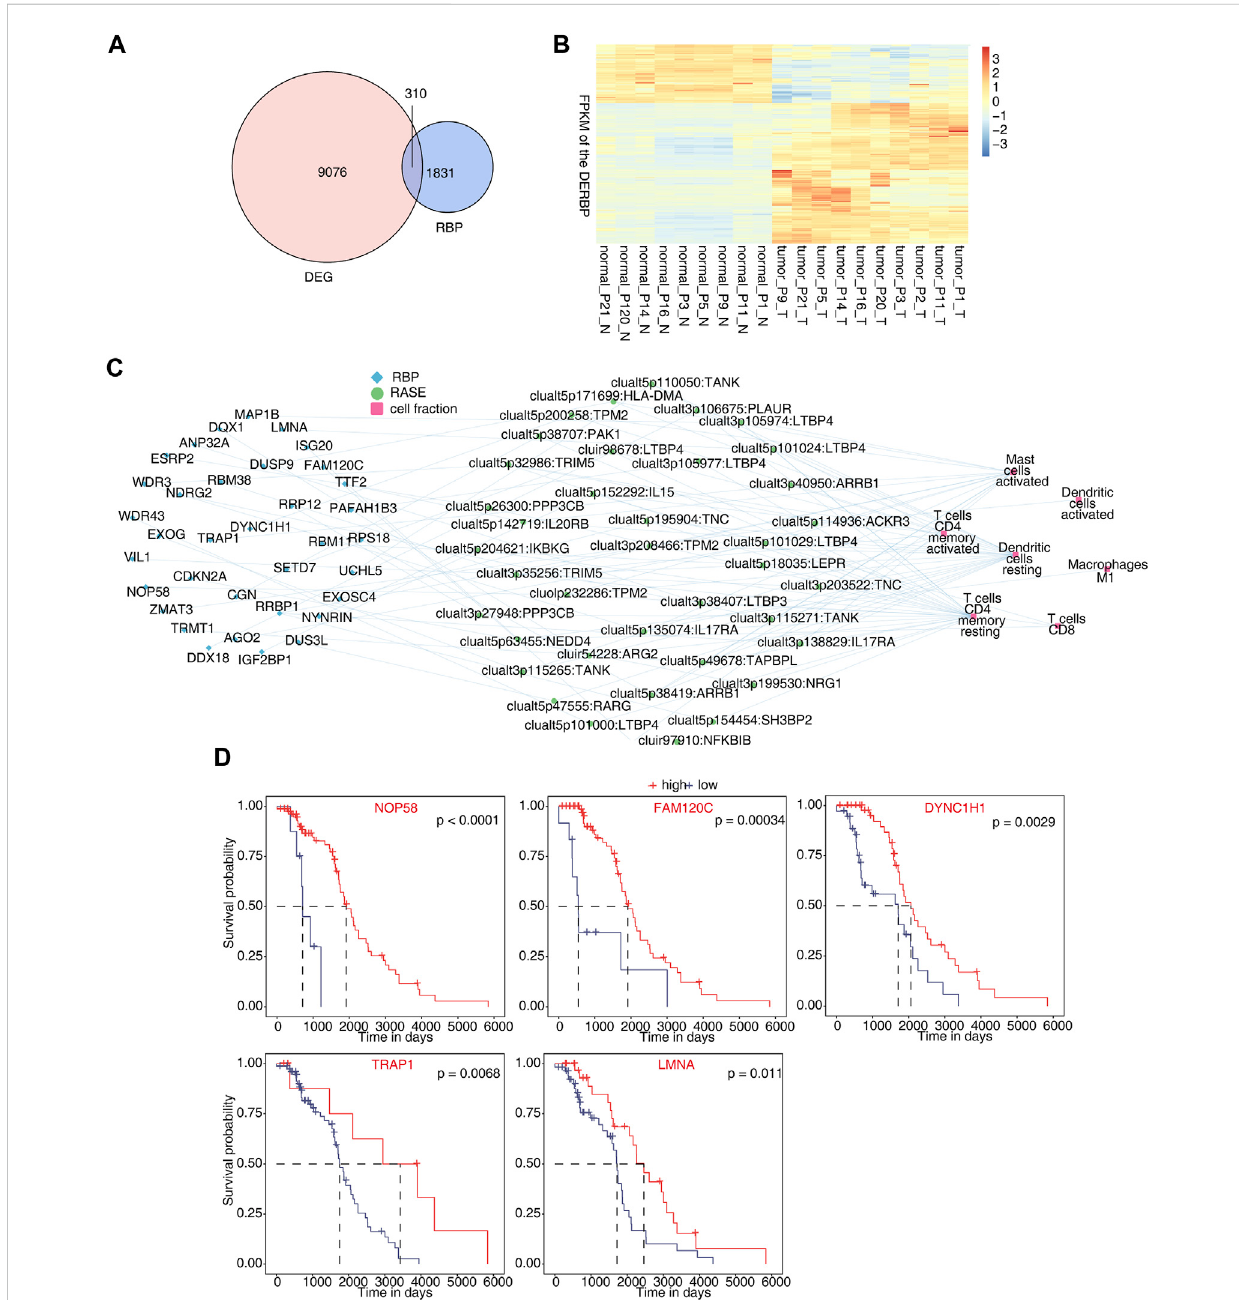
FIGURE 4 Identi fi cation of differentially expressed RBPs co-disturbed with immune-related osteosarcoma-RAS. (A) Venn diagram showing the overlap gene number of RBPs and DEGs. (B) Hierarchical clustering heatmap showing the FPKM of the DERBPs. (C) Network showing the immune cells regulated by DERBP and RASEs. (D) Survival curves regulated by NOP58, FAM120C, DYNC1H1, TRAP1, and